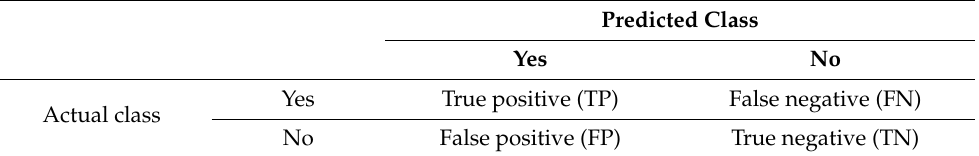
Table 3. Confusion matrix